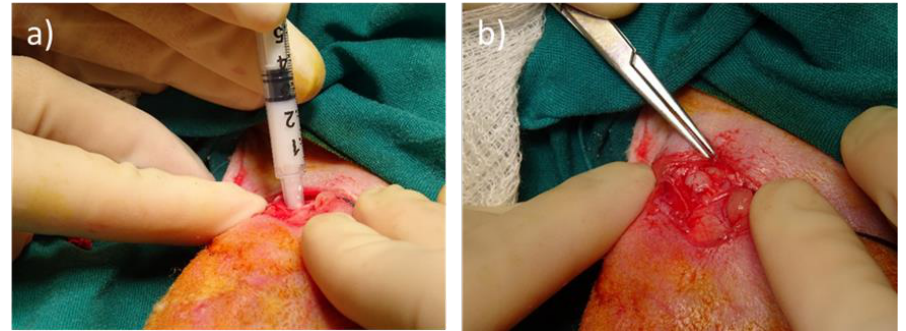
Figure 6. MBNP – hyaluronic acid implantation as an injectable material ( a ); Image of the defect filled with the gelled material ( b ).